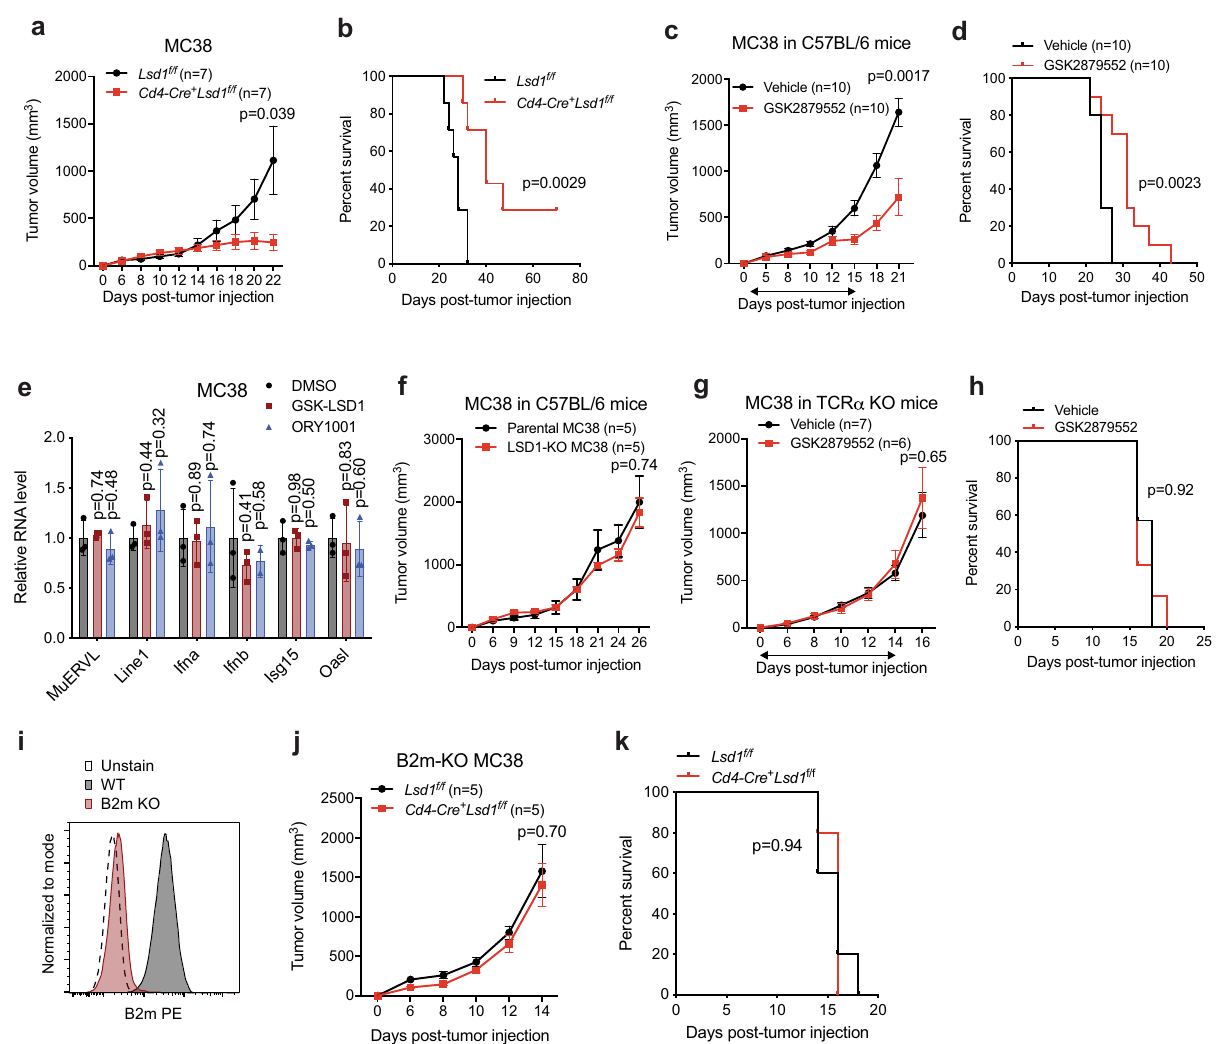
Fig. 1 LSD1 inhibition in T cells enhances antitumor immunity in MC38 tumor model. a , b Tumor growth ( a ) and survival curves ( b ) of Lsd1 f/f and Cd4-Cre + Lsd1 f/f mice subcutaneously inoculated with MC38 tumor cells ( n = 7 per group). c , d Tumor growth ( c ) and survival curves ( d ) of wildtype mice inoculated with MC38 tumor cells and treated with LSD1 inhibitor GSK2879552 or vehicle control daily for 2 weeks (arrow line). e The real-time qPCR analysis of IFN-related genes in cultured MC38 cells treated with 2 μ M GSK-LSD1, 0.5 μ M ORY1001 or vehicle control for 5 days ( n = 3). f Tumor growth curves of wildtype mice inoculated with wildtype parental or Lsd1 KO MC38 tumor cells. g , h Tumor growth ( g ) and survival curves ( h ) of TCR α KO mice inoculated with wildtype MC38 tumor cells and treated with GSK2879552 or vehicle control daily for 2 weeks (arrow line, vehicle group, n = 7; GSK2879552 group, n = 6). i Flow cytometry analysis of B2m expression by WT and B2m KO MC38 cells. j , k Tumor growth ( j ) and survival curves ( k ) of Lsd1 f/f and Cd4-Cre + Lsd1 f/f mice inoculated with B2m KO MC38 tumor cells ( n = 5 per group). Data represent two independent experiments and are presented as mean±SEM (standard